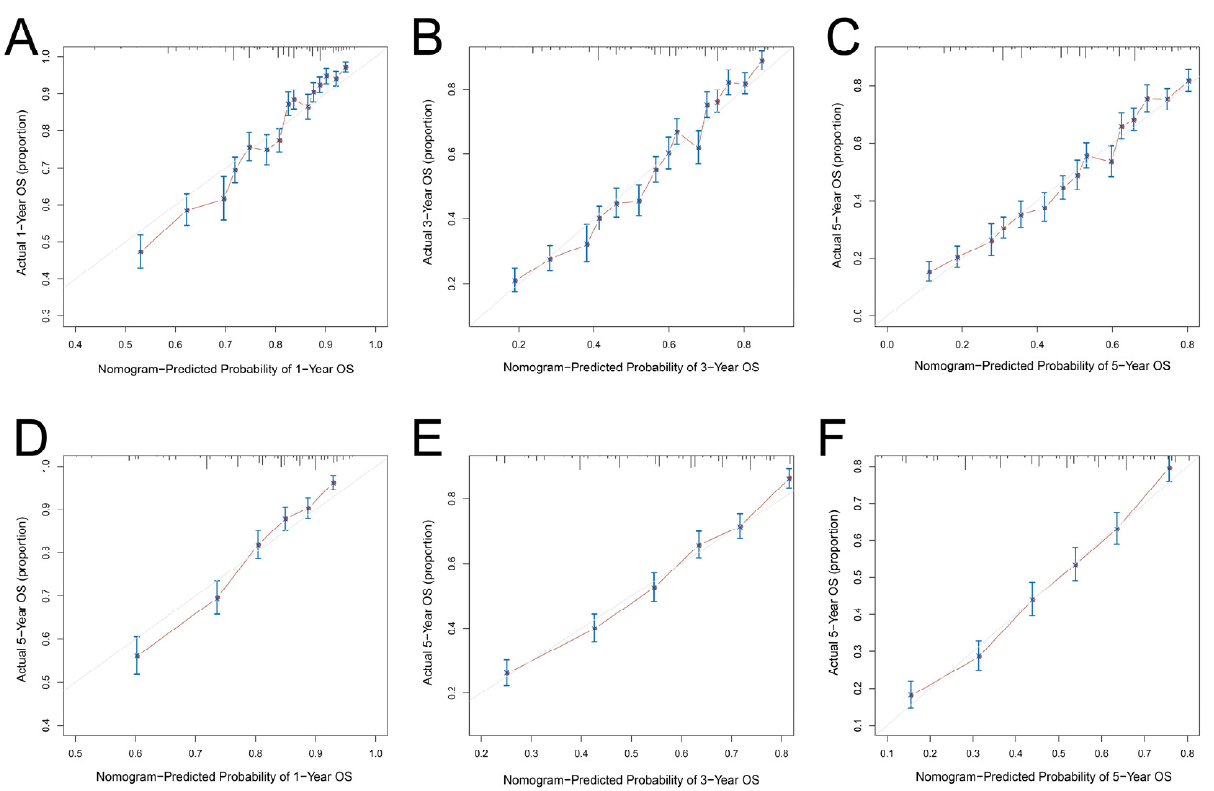
Figure 4. Receiver operating characteristic curve of the nomogram in the training ( A ) and validation ( B ) cohorts.